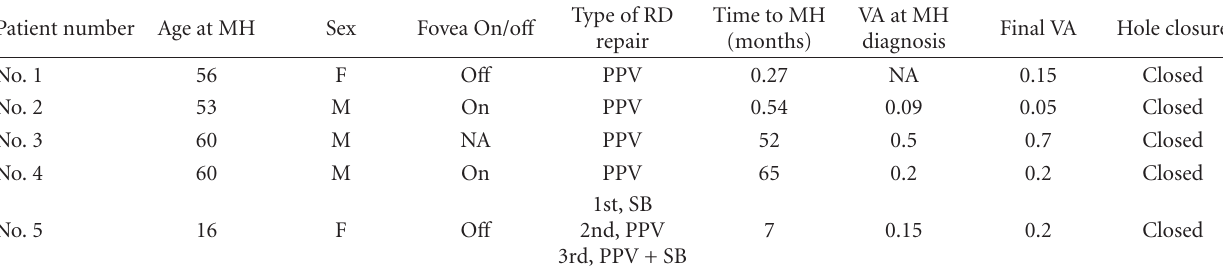
Table 1: Patient’s